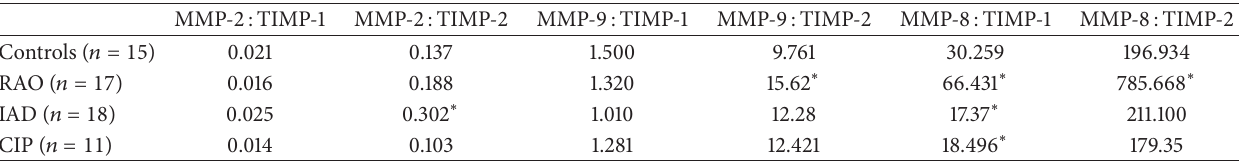
Table 7: MMP:TIMP ratios. ∗ shows significant differences to controls at 𝑝 < 0.05 . RAO: recurrent airway obstruction, IAD: inflammatory airway disease, and CIP: chronic interstitial